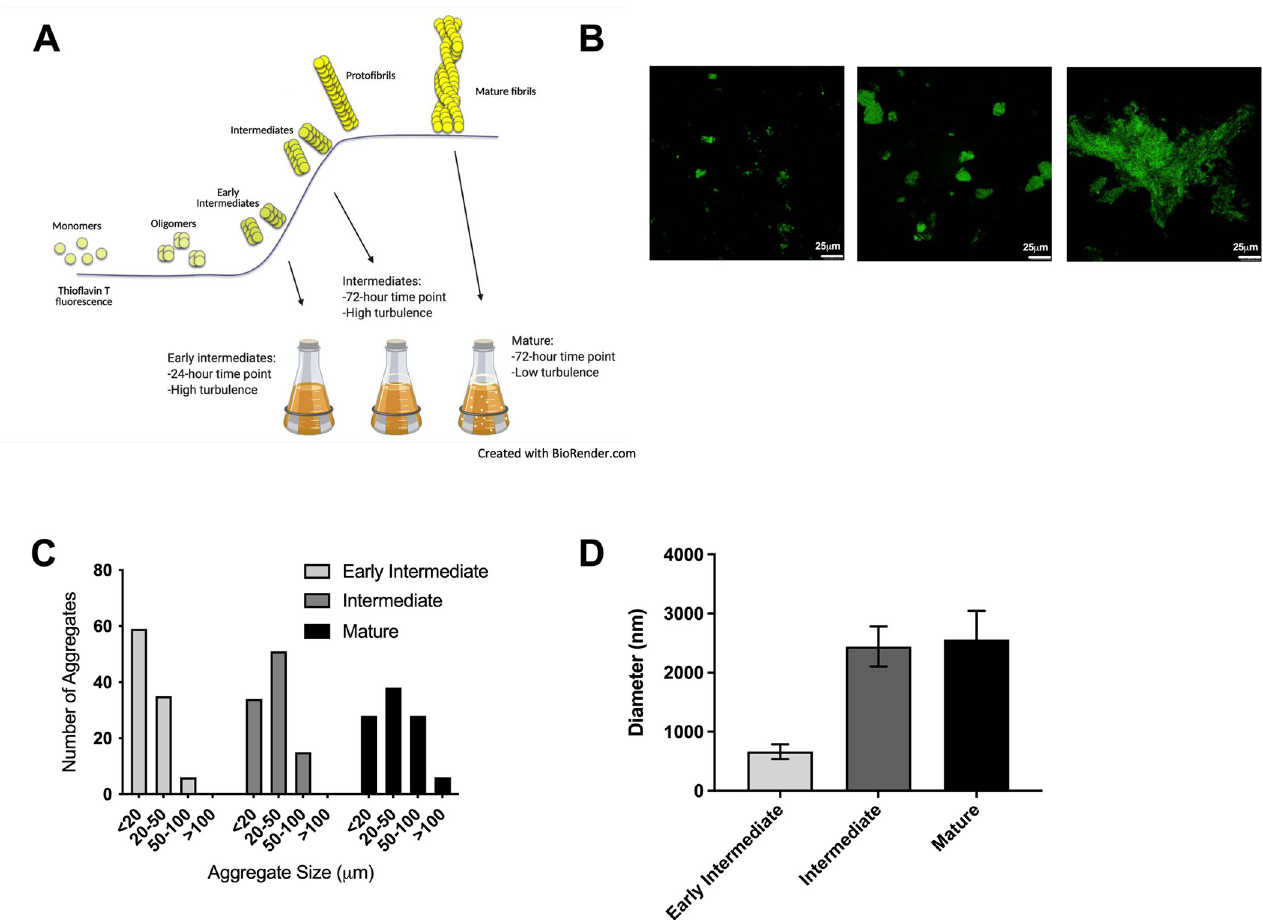
Fig 1. Characterization of sizes of curli-containing aggregates during the biofilm maturation. (A) Fibrillization curve showing the intensity of ThT stain, as a result of ThT incorporation, during maturation of the amyloid fibril from monomer to intermediate to mature fibrils. The bottom right of the image gives information about growth and collection conditions used to isolate the early intermediate, intermediate, and mature curli complexes. Aggregates are visible under conditions for collection of mature complexes. (B) Representative confocal microscopy images of samples of early intermediate (left), intermediate (middle), and mature (right) curli aggregates. Samples from 400 μ g/mL stocks of each form were stained with 100 μ M ThT and imaged at 60x magnification. Scale bars are 25 μ m. (C) Number of aggregates at indicated sizes in samples of early intermediate, intermediate, and mature curli calculated from confocal microscopy images. One hundred aggregates were counted for each condition. (D) Diameters of aggregates in samples of early intermediate, intermediate, and mature curli determined by dynamic light scattering. The difference in diameters of intermediate and mature fibrils was not significant.